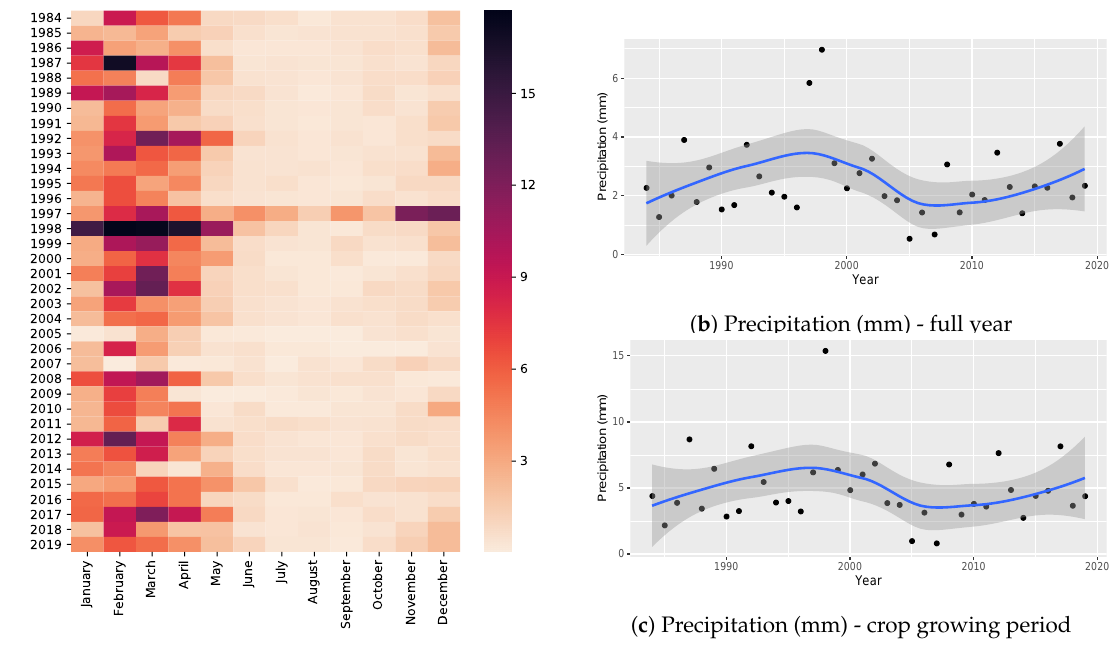
Figure A2. Time series of daily average precipitation (mm) in Guayas from 1984 to 2019. ( a ) Heat-map of daily precipitation (mm) per each month and year. The color scale represents the precipitation in mm. ( b ) Daily precipitation averaged during the full year. ( c ) Daily precipitation averaged during the maize crop growing period in Ecuador (January–May). Each dot represents one record, the blue line shows the smoothed time series and the shaded area represents the 95% confidence interval.